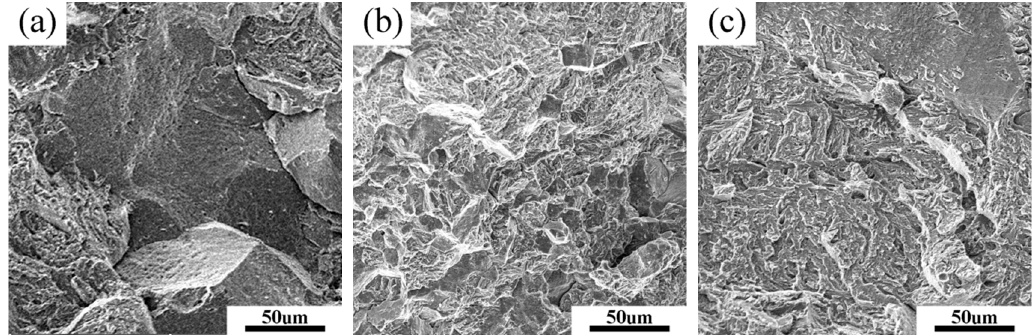
Figure 8. Fractograph of the tensile sample with the heat input of 5.4 kJ/cm. ( a , b ) Fusion zone fracture; and ( c ) tempering zone fracture.